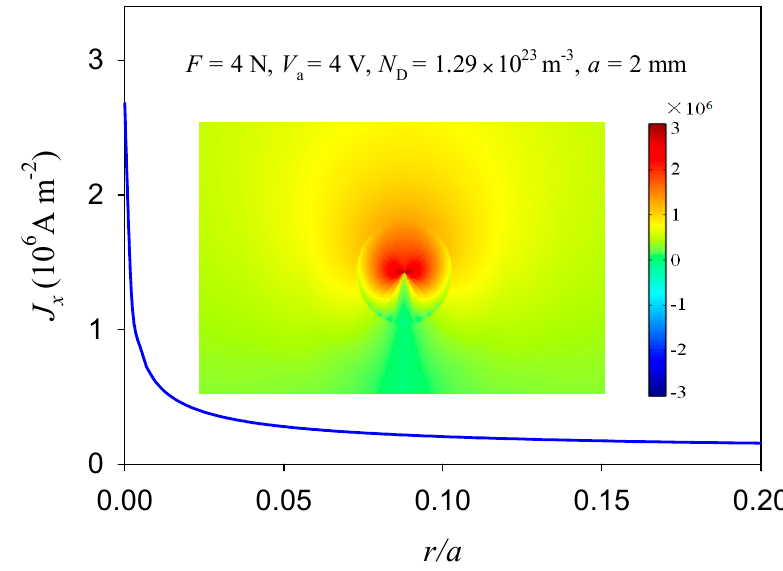
Figure 12. The electric current density distribution in the extension of a crack tip (see Figure 2) and the corresponding nephogram near the crack tip.